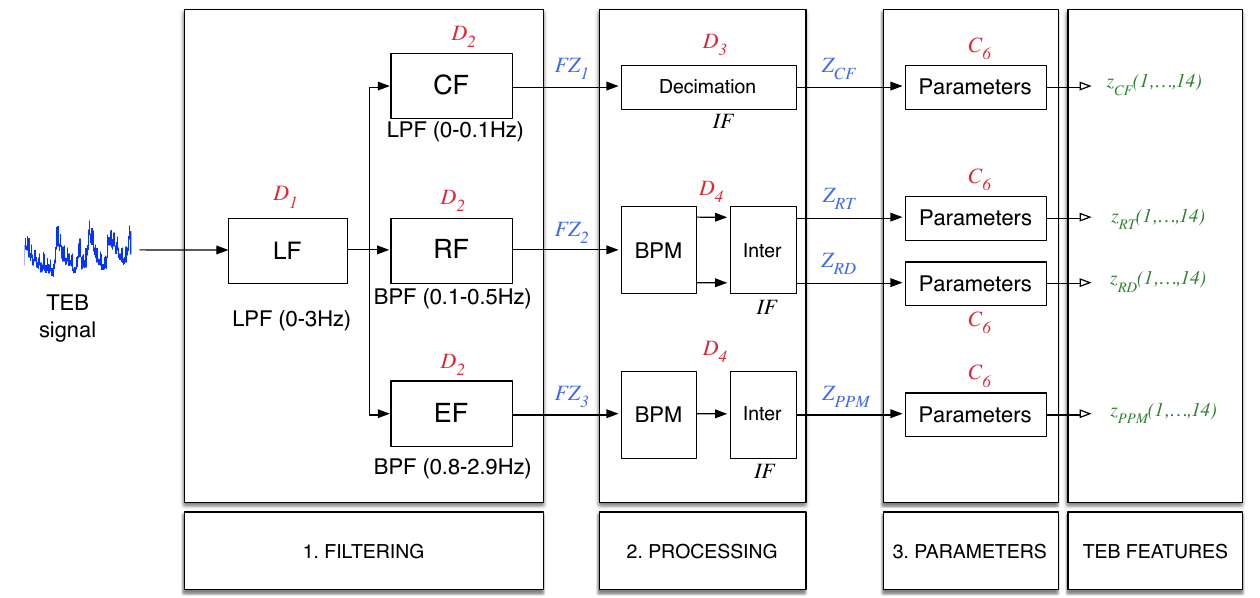
Figure 7. Thoracic electrical bioimpedance (TEB)-based feature extraction